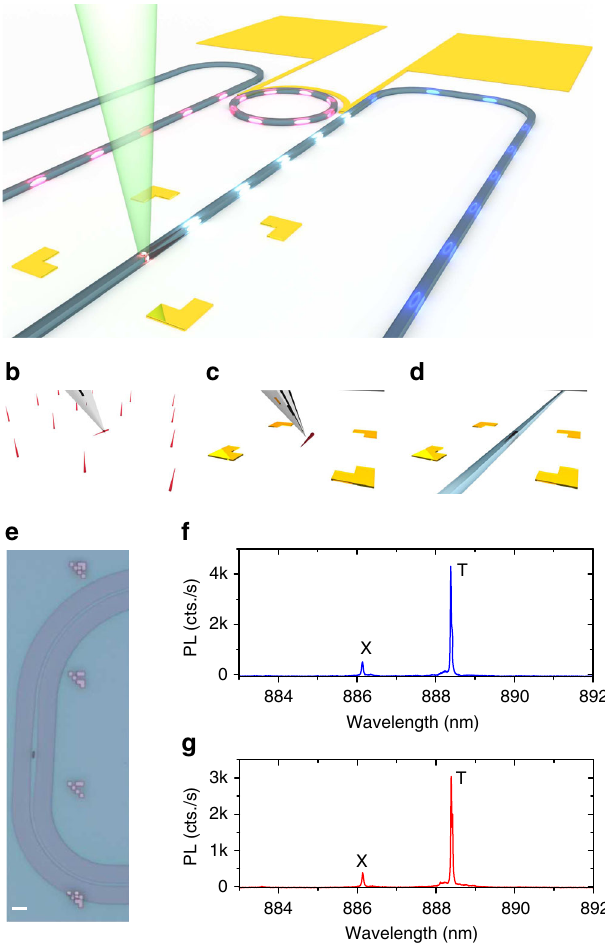
Fig. 1 Hybrid quantum photonic circuit. a Schematic view of the fabricated hybrid quantum photonic circuit, consisting of an InAsP QD in an InP nanowire ( ruby coloured) that is integrated with a SiN waveguide ( blue ) and on-chip tunable ring resonator fi lter. The ring resonator fi lter is tuned by applying voltage to the gold contacts ( orange ). The out-of-plane laser ( green ) excites the QD, which emits single photons ( ellipsoids ) into the waveguide. b – d The CMOS compatible process fl ow for integrating the nanowire-based quantum light sources within the hybrid quantum photonic circuit. Using a custom-built tungsten nanomanipulation tool, the nanowires are transferred from the growth chip to the selected photonic circuit substrate. e A microscope image of an integrated single-photon source with a SiN photonic waveguide, the scale bar has length of 5 µ m. Emitted photons are coupled to the SiN photonic channel with the possibility to collect both forward and backward photons independently. The photonic circuits are fabricated with respect to the transferred quantum emitters as described in the Methods section. f , g The collected forward and backward photoluminescence (PL) from the nanowire QD, respectively. T and X represent the trion and exciton emission lines,